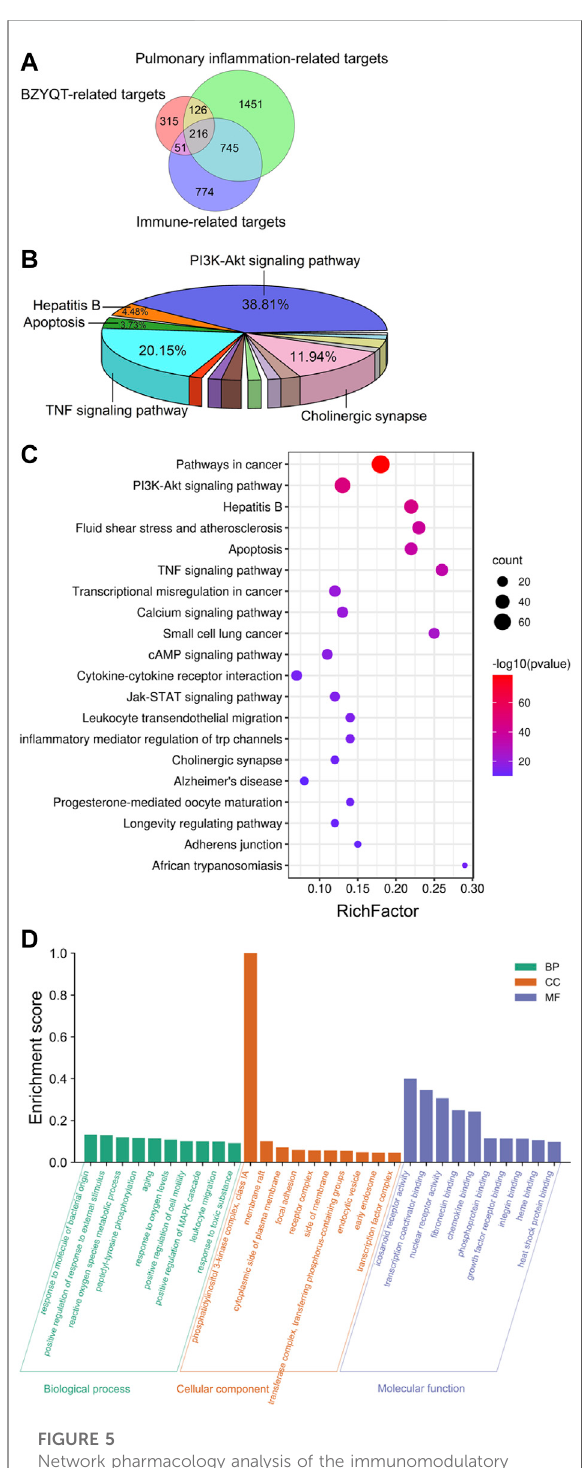
FIGURE 5 Network pharmacology analysis of the immunomodulatory effectsofBZYQTforpulmonaryin fl ammation. (A) Venndiagramof BZYQT-related targets, lung in fl ammation-related targets, and immune-related targets; (B) Pie chart of KEGG pathway cluster of BZYQT after hierarchical clustering analysis; (C) Bubble chart of 20 KEGG pathway cluster of BZYQT (the size of the circle means the gene number that hit in the pathway; the rich factor